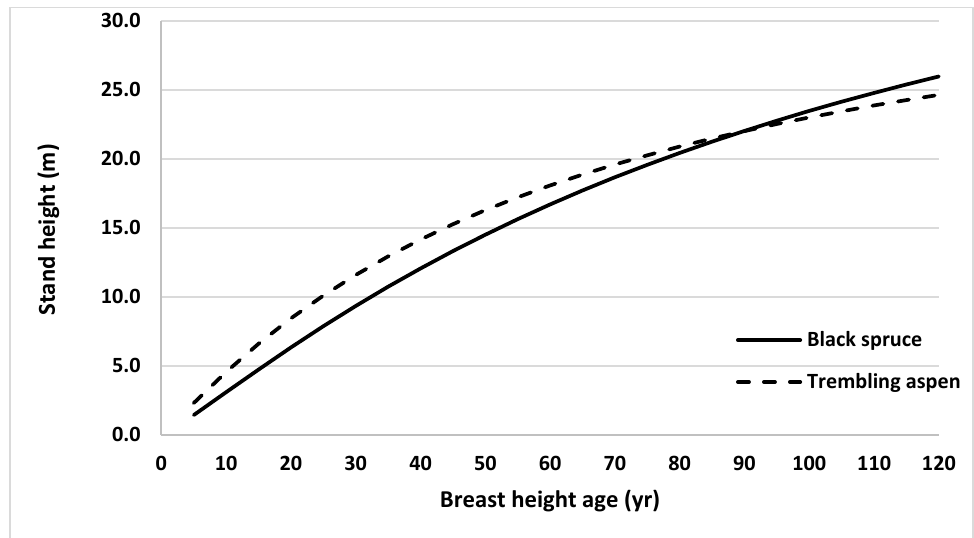
3 of Sharma and Reid (2018).